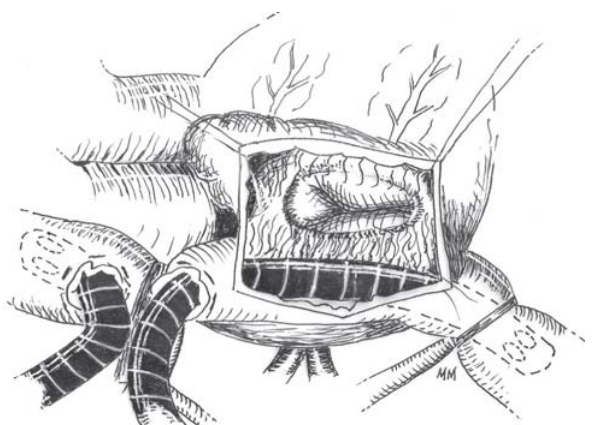
Fig. 3 - Canulação da veia cava superior através dela mesma e canulação da veia cava inferior através da aurícula